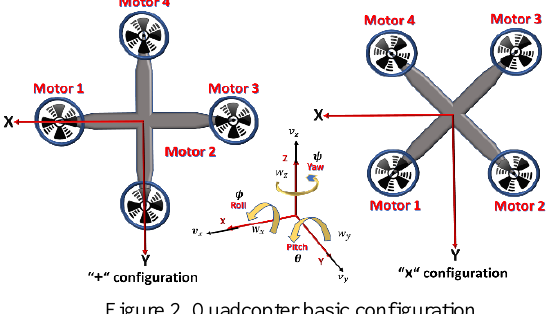
Figure 2. Quadcopter basic